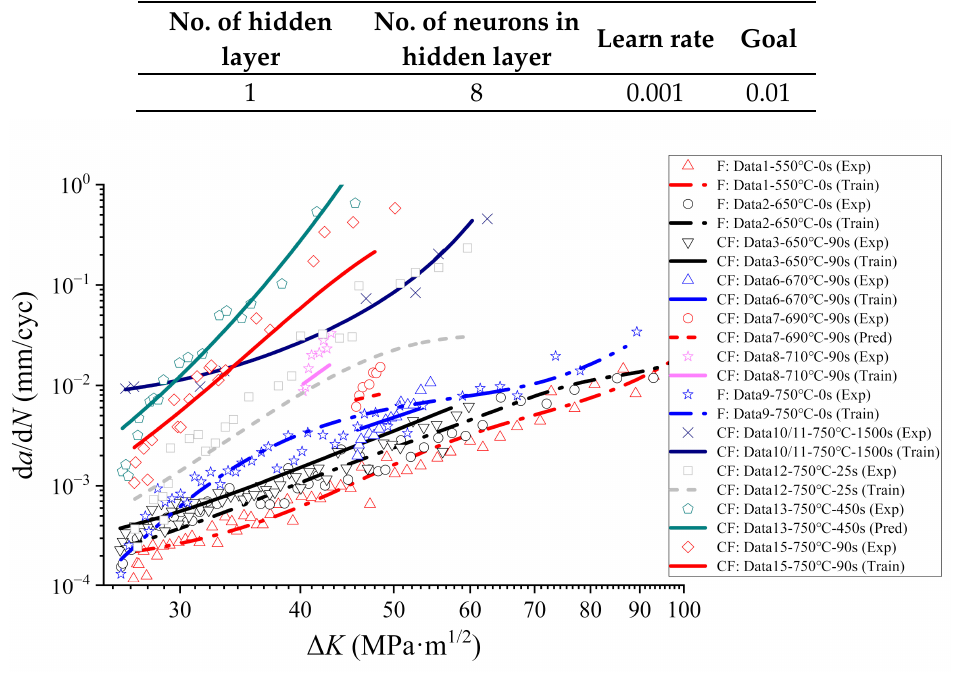
Figure 7. Prediction of the evolution of d a /d N with ∆ K under different elevated temperatures (650–750 °C) and different holding times (t hold from 0 to 1500 s).